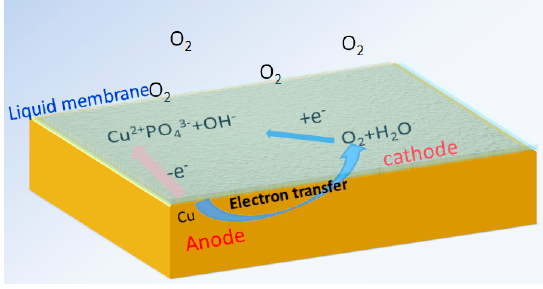
Figure 11. Schematic of the formation of Cu 3 (PO 4 ) 2 nanoflowers.